Question: Provide a publication-style caption for this figure.
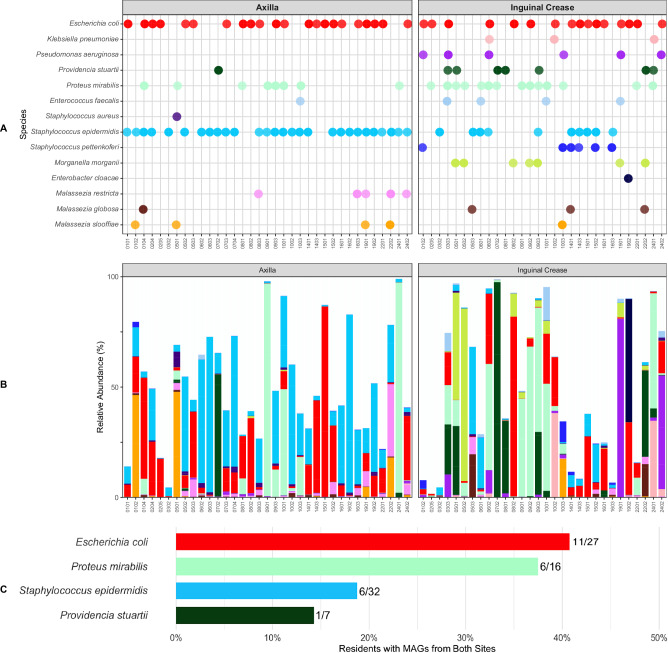
Answer: MDRO colonization of nursing home residents’ skin characterized by MAG recovery and abundance. A Recovery per resident at any timepoint of near-complete bacterial and fungal MAGs colored for representative species. Detailed overview of MAGs per resident per species are displayed in Supplementary Fig. 2A . B Relative abundance of same representative bacteria and fungi in shotgun metagenomic sequencing samples. Colors are defined in ( A ). C Frequency of MAG recovery from both inguinal crease and axilla of the same resident.